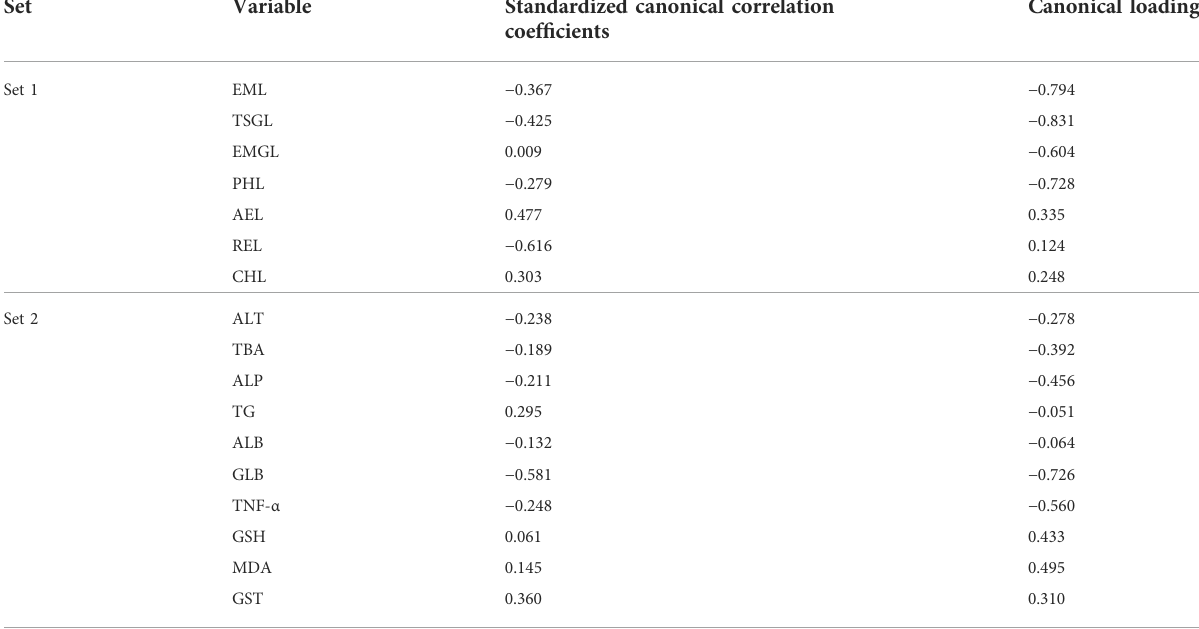
TABLE 4 Canonical correlation coef fi cients between hepatic exposure and biochemical index in this PM hepatotoxicity study ( n = 6).